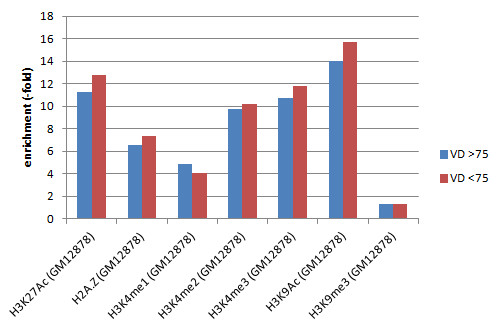
Overlap of VDR ChIP-seq peaks with chromatin marks. 25(OH)D ≥75, samples with 25-hydroxyvitamin D ≥75 nM; 25(OH)D <75, samples with 25-hydroxyvitamin D <75 nM; ChIP-seq, chromatin immunoprecipitation and massively parallel sequencing; VDR, vitamin D receptor. All bars shown are significant at P<0.0001.